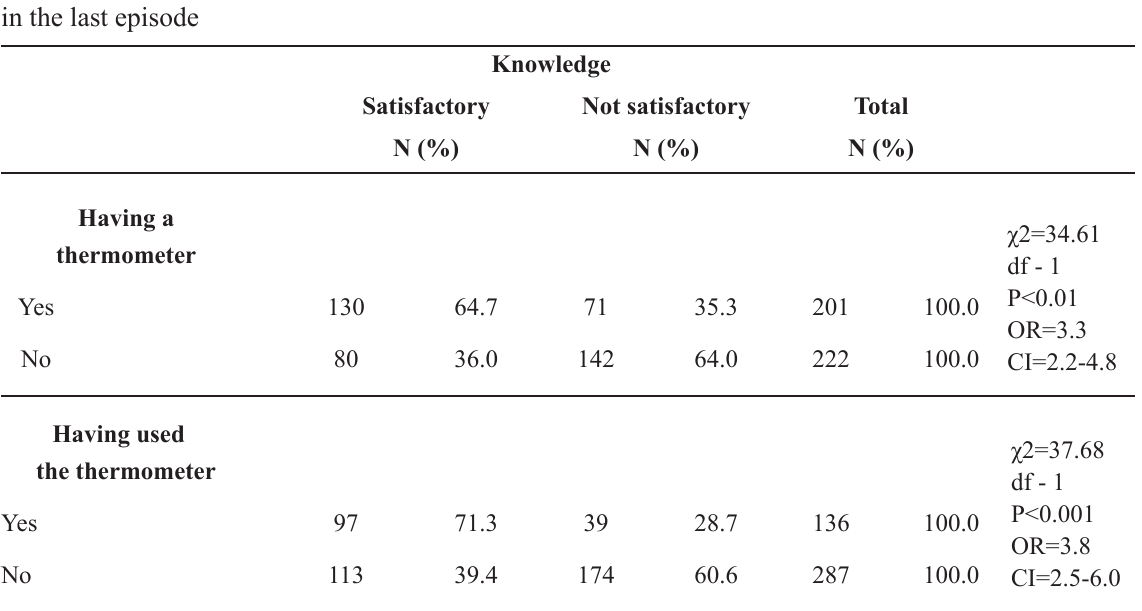
Table 3 Association between the level of knowledge versus having a thermometer and having used it in the last episode